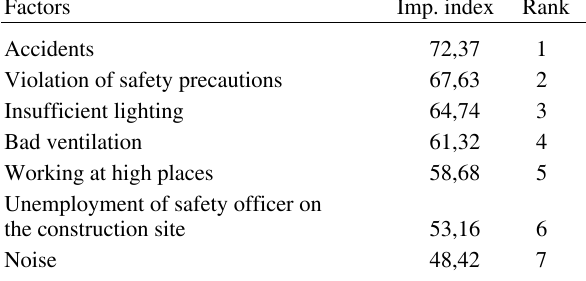
Table 8. Ranking factors under safety